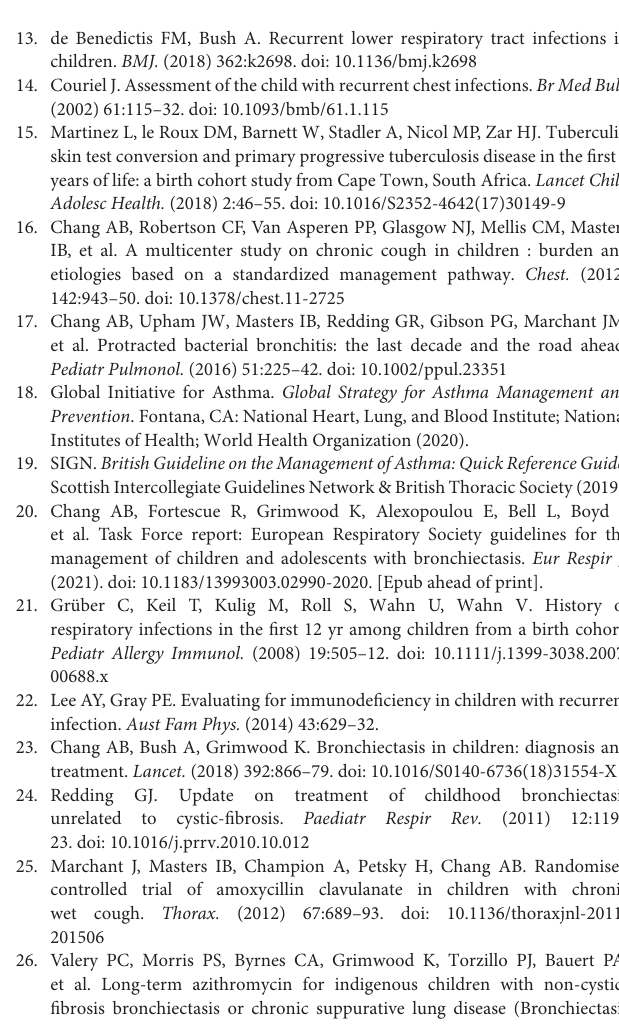
Supplementary Figure 1 | Pathway for children that require further investigation. Supplementary Figure 2 | Patterns of lower respiratory tract symptoms over a 12 month period [Adapted Penny ME. Pediatr Infect Dis. (1993) 12:762–3]. Supplementary Figure 3 | Infographic demonstrating how airway obstruction by a foreign body (B) or impairment of muco-ciliary mechanism (C) result in stasis of secretions and inflammation as compared to normal (A) . Supplementary Figure 4 | Managment steps of children with chronic respiratory symptoms or at-risk of respiratory